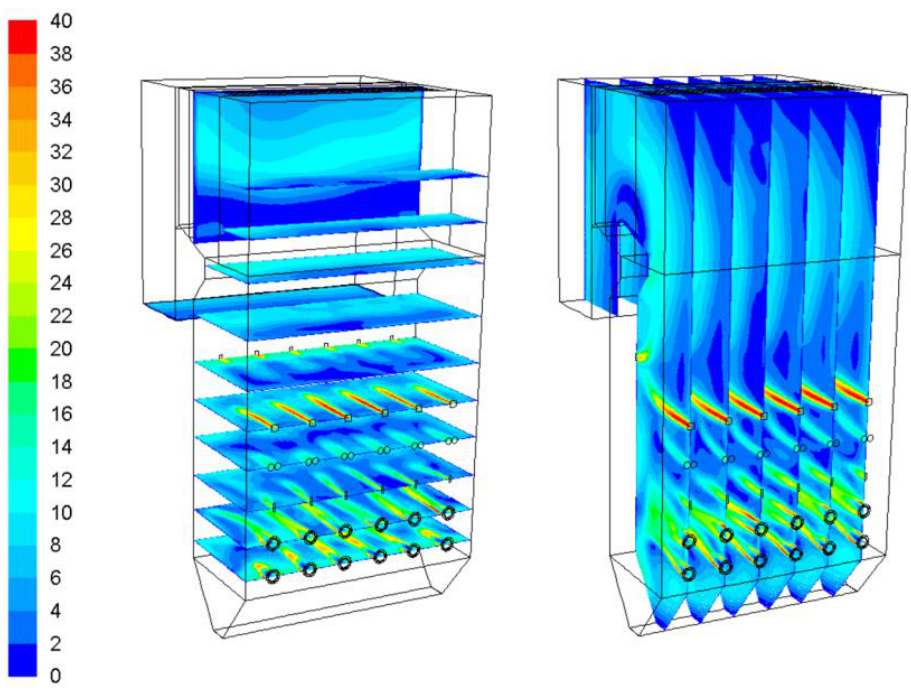
Figure 6. Velocity profile (m/s) in the planes of the burner axis. Table 7. Average velocities (m/s) as area-weighted average in plane behind the individual heat exchange surfaces.